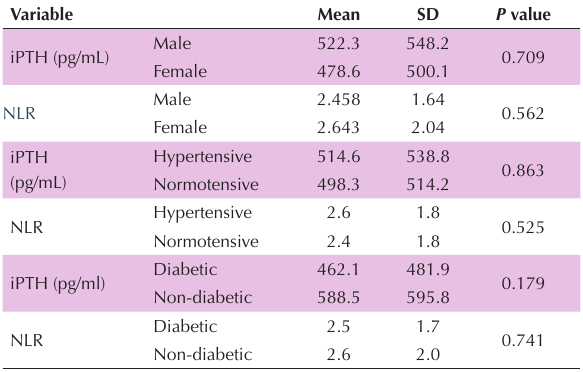
Table 2. Comparison of the iPTH and NLR across gender, diabetes mellitus and hypertension Variable